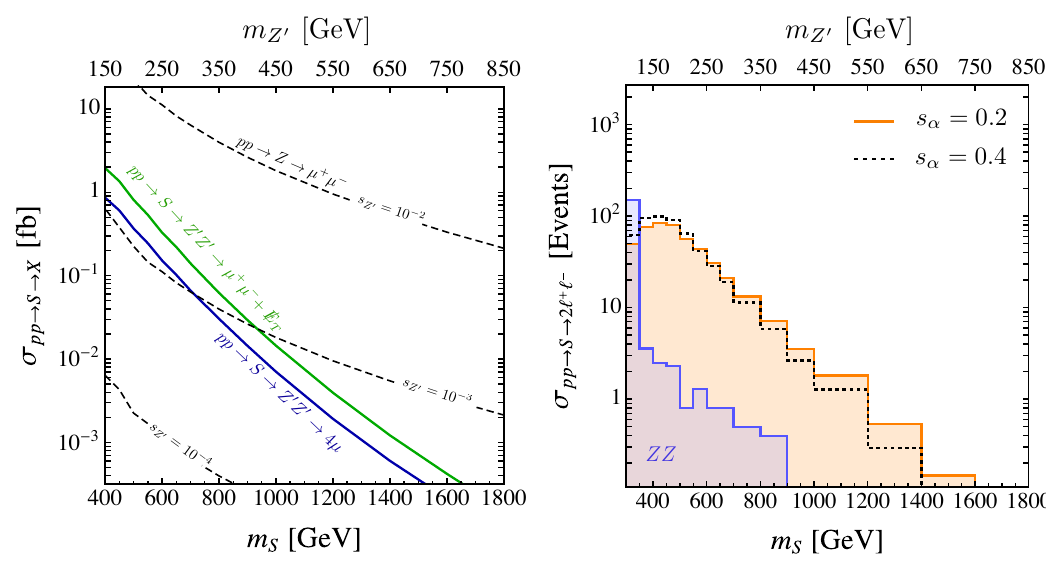
Figure 11: Left: S -induced mono- Z (cid:48) and four-muon signal rates compared to the = 10 − 2 ,10 − 3 ,10 − 4 . Right: signal and background events di-lepton resonance for s Z (cid:48) for pp → S → 4 µ assuming s α = 0.2 and 0.4 after all